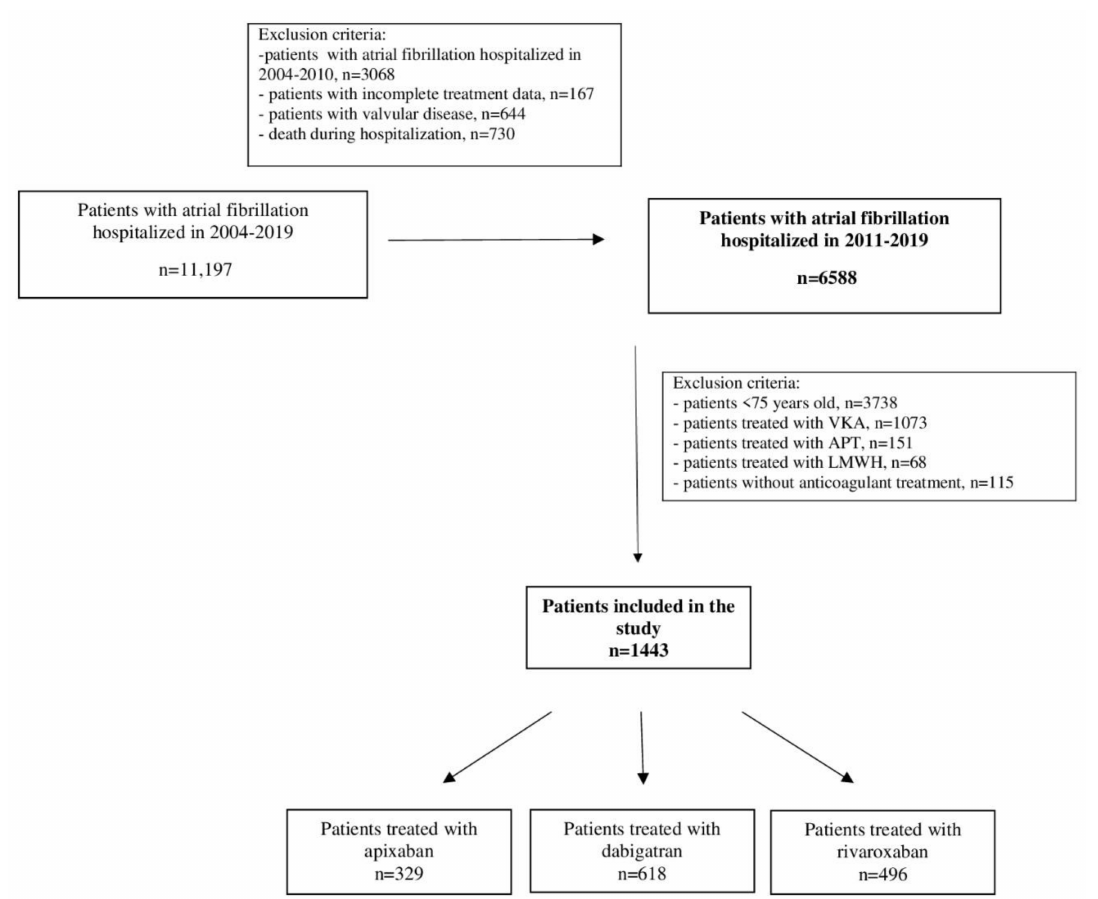
Figure 1. The flow chart of the study. Abbreviation: APT, antiplatelet drug; LMWH, low mass weight heparin; VKA, vitamin K